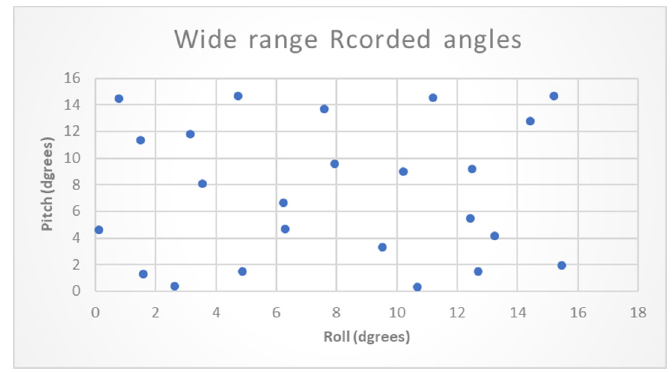
Figure 10. Experiment wide range recorded angles distribution.